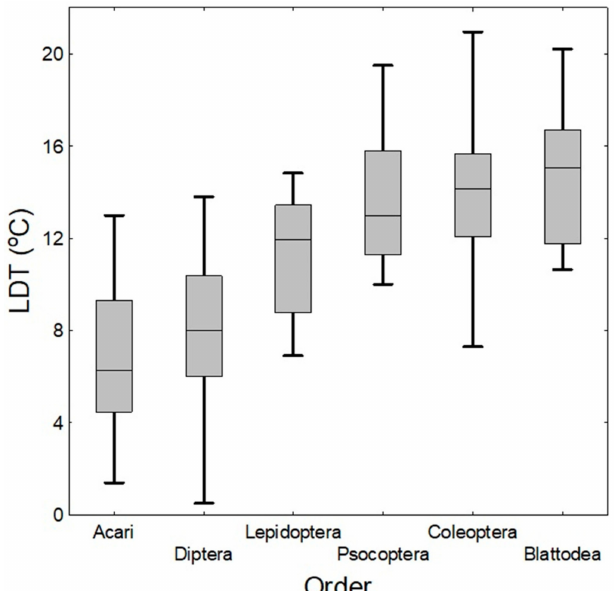
Figure 1. Boxplots of LDTs in all orders. Median of LDT for Acari = 6.28 ◦ C, for Diptera = 8.0 ◦ C, for Lepidoptera = 11.96 ◦ C, for Psocoptera = 13.0 ◦ C, for Coleoptera = 14.15 ◦ C, and for Blattodea = 15.05 ◦ C. (Horizontal lines inside the boxes represent median values, upper and lower boxes represent the 75th and 25th percentiles, respectively, and upper and lower whiskers represent the 99th and 1st percentiles, respectively).